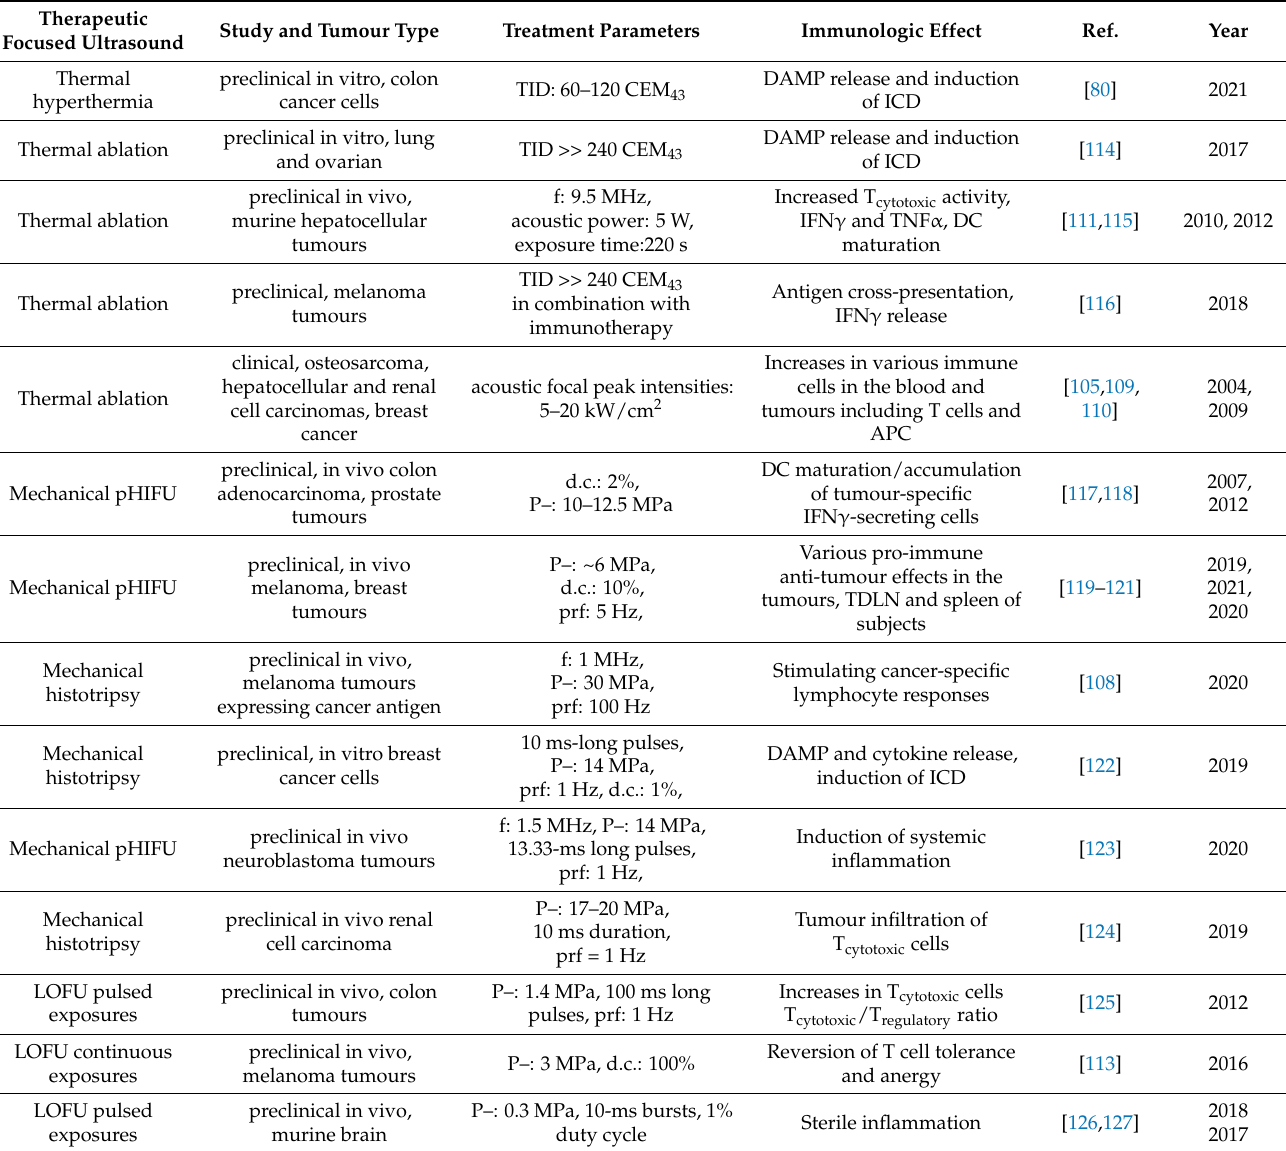
Table 2. Seminal studies showing focused ultrasound-induced immune effects in tumours of non- pancreatic